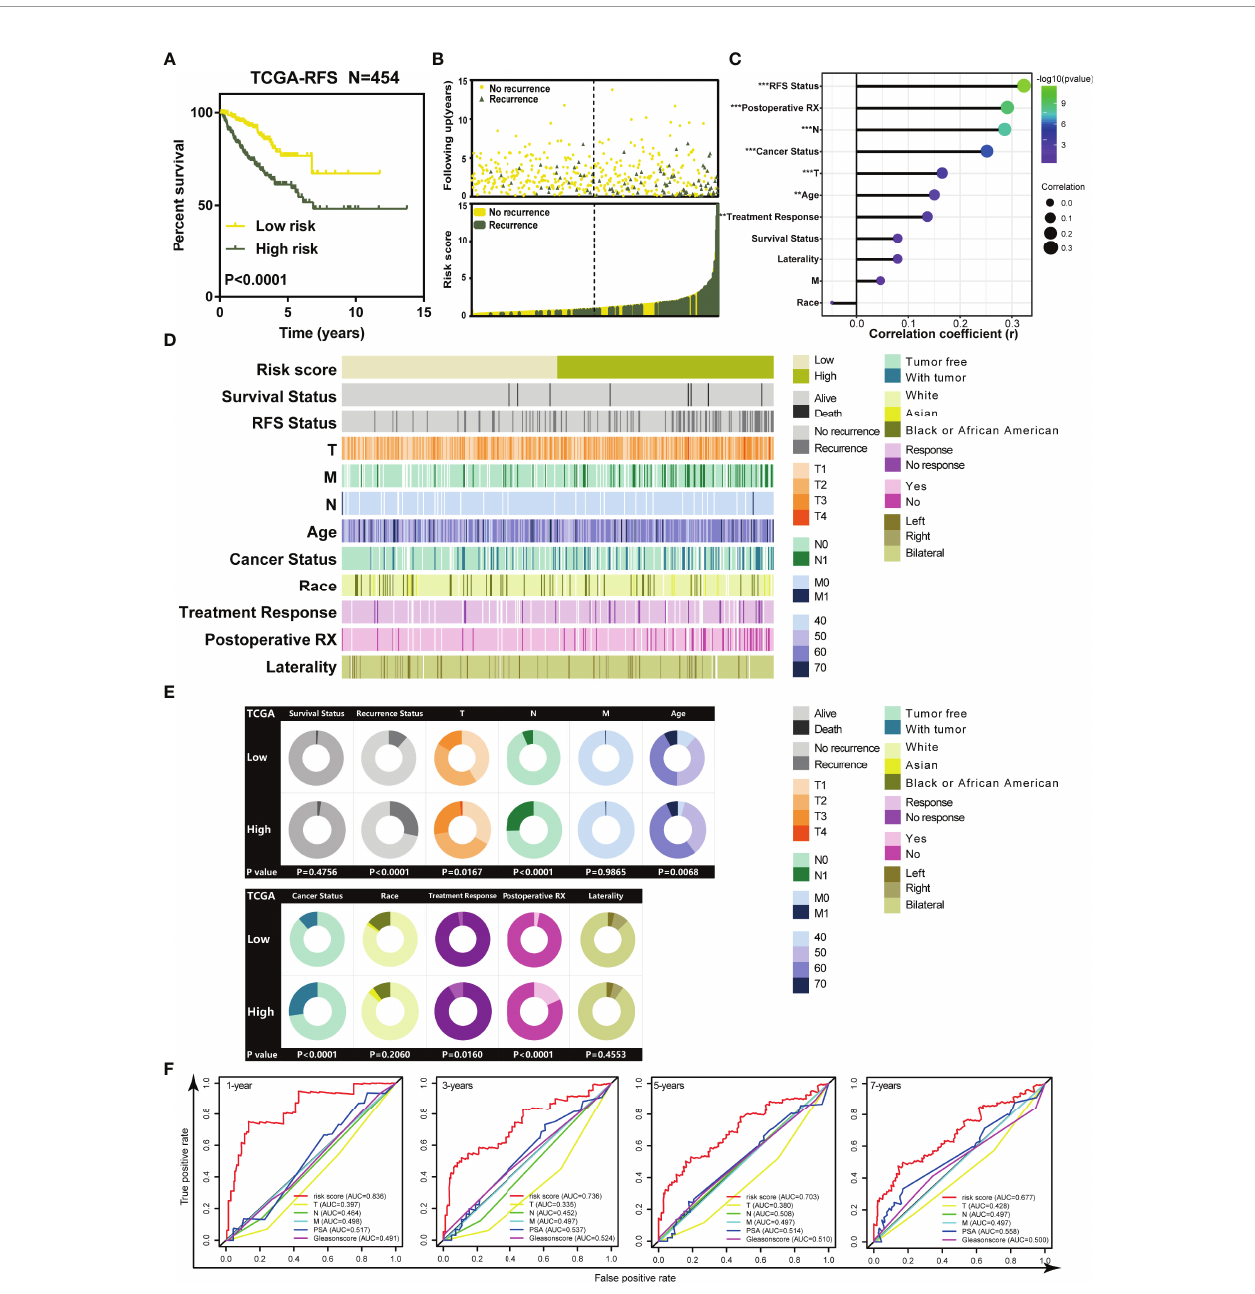
FIGURE 2 | The TILTregSig can serve as a biomarker for RFS of prostate cancer patients in both TCGA and ICGA datasets. (A) Kaplan – Meier curves of RFS of low- and high-risk groups strati fi ed by the TILTregSig in prostate cancer patients in the TCGA dataset. (B) The distribution of gene risk scores and patients ’ recurrence status for prostate cancer patients in the TCGA dataset. (C) Correlation analysis between risk score and clinical characteristics in prostate cancer. R : Spearman ’ s correlation coef fi cient. (D) The strip chart of risk score and clinical characteristics for patients with prostate cancer in the TCGA dataset. (E) Pie charts showing the chi-square test of clinicopathologic factors for low- and high-risk groups in prostate cancer samples from the TCGA dataset. (F) Comparison of predictive ability of TILTregSig, PSA levels, Gleason score, Clinical T, Clinical N, and Clinical M for RFS of prostate cancer in 1, 3, 5, and 7 years using ROC curve analysis. **, P<0.01. ***,